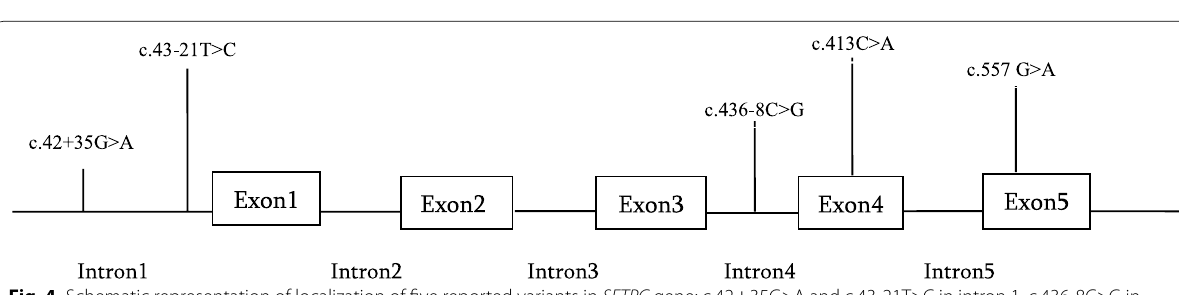
Fig. 4 Schematic representation of localization of five reported variants in SFTPC gene: c.42 intron 4, c.413C>A in exon 4, and c.557G>A in exon